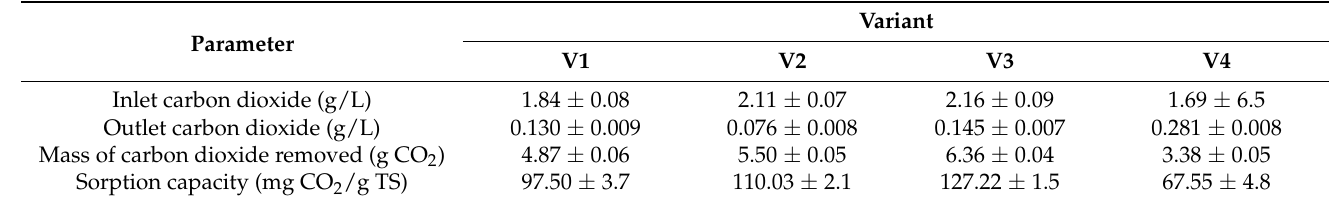
Table 3. The sorption capacity calculated on the basis of carbon dioxide concentration in biogas inlet and outlet through the fixed-bed column.